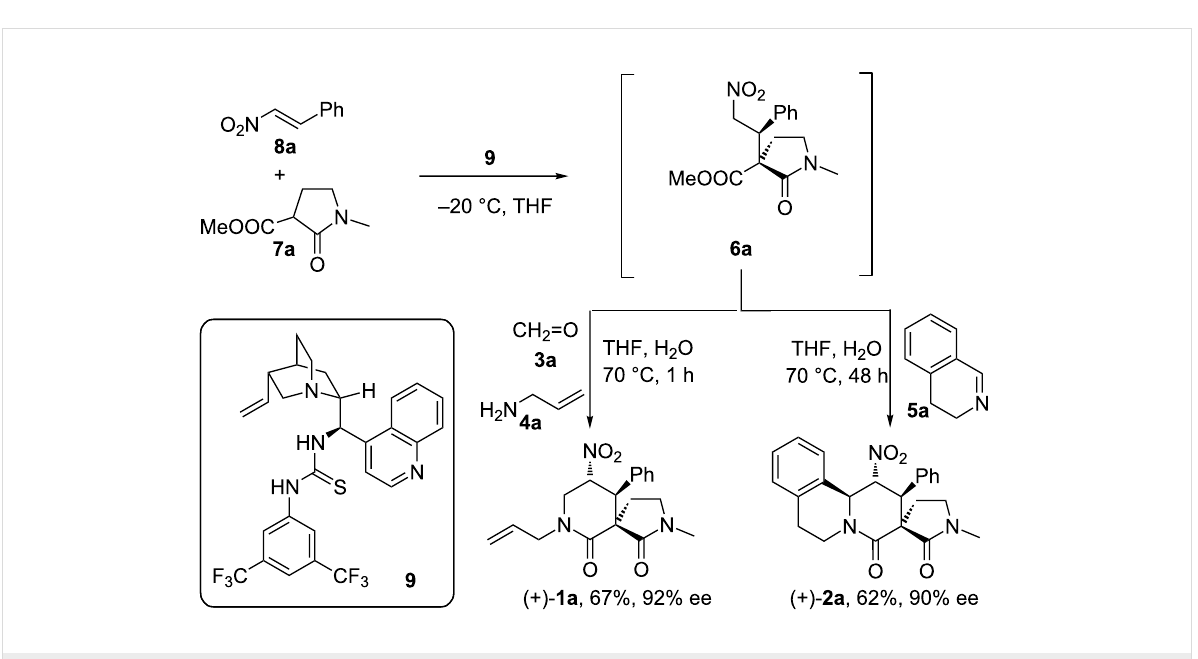
Scheme 8: One-pot three/four-component enantioselective Michael addition/nitro-Mannich/lactamisation